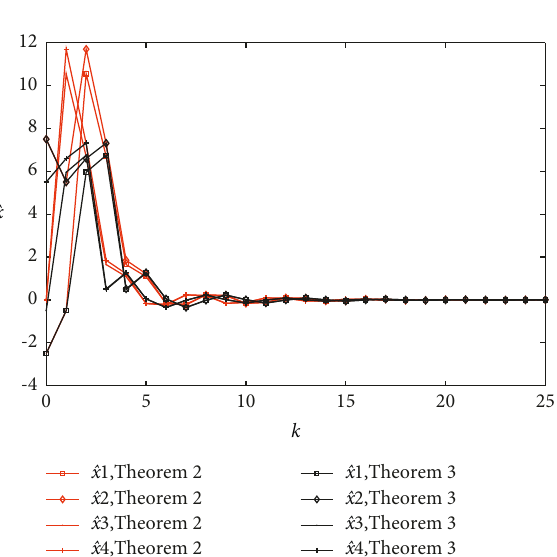
Figure 13: Estimated state trajectory with δ � 0 .